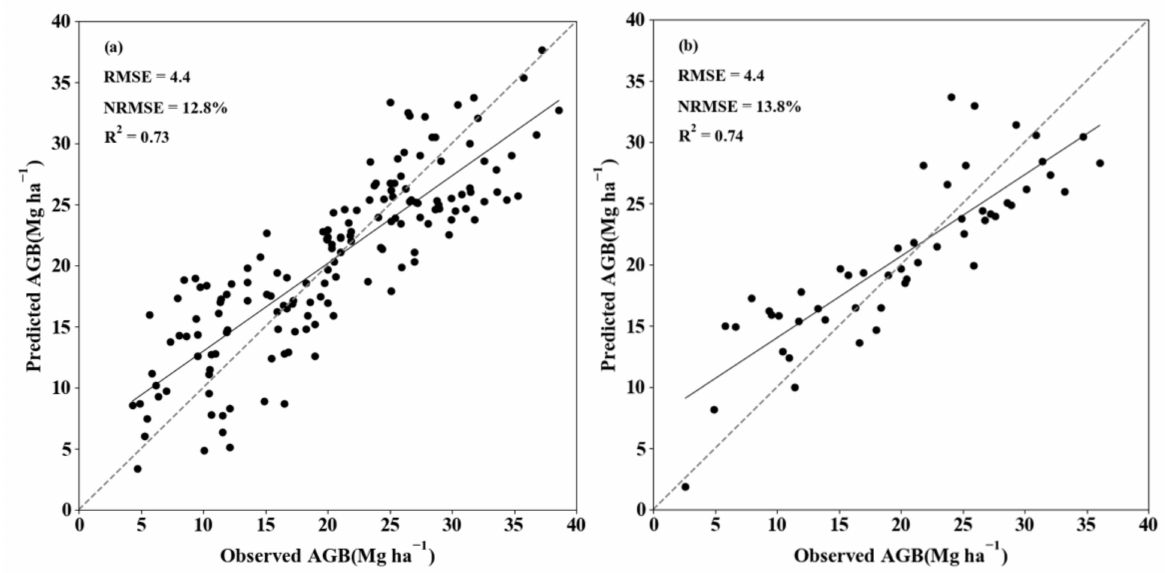
Figure 7. Comparison between observed and predicted AGB by the GWR model with ( a ) training samples and ( b ) test- ing